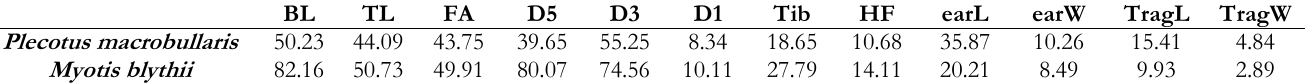
T ABLE 1. Morphometric measurements (mm) for Plecotus macrobullaris Kuzjakin, 1965. BL= Body length; TL= Tail length; FA= Forearm-length; D5= Length of fifth finger; D3= Length of third finger; D1= Length of thumb; Tib= Length of tibia; HF= Length of hind foot; earL = Length of ear; earW= Width of ear; TragL= Length of tragus; TragW= Width of tragus.